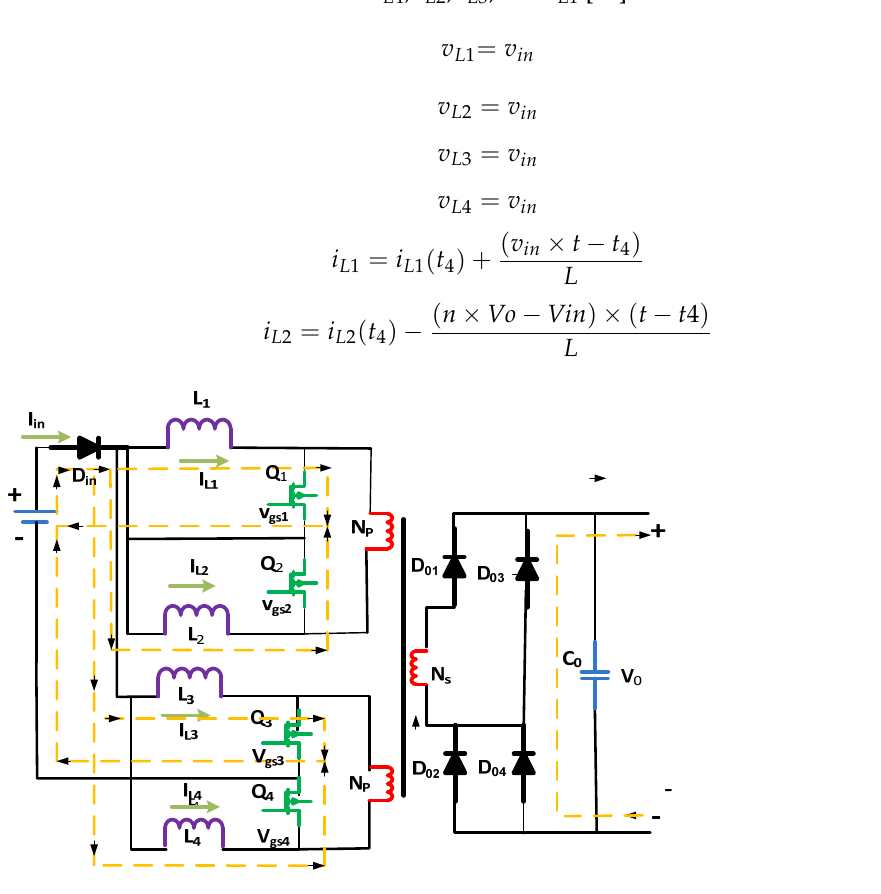
Figure 6. Fourth mode of the circuit.